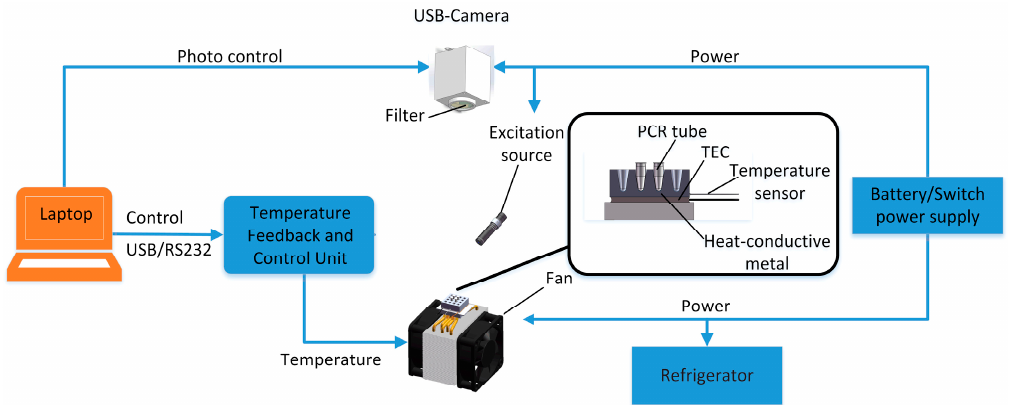
Figure 1. An overview of the HDLRT-qPCR system. The system can be powered by either lithium batteries or an external power supply. Micro-stepper motor-switched multiple filters in front of the USB camera are used to acquire data from multiple fluorescence channels. The temperature cycle of the thermoelectric cooler (TEC) is modulated by a control unit. The fluorescence information is collected using a USB camera.